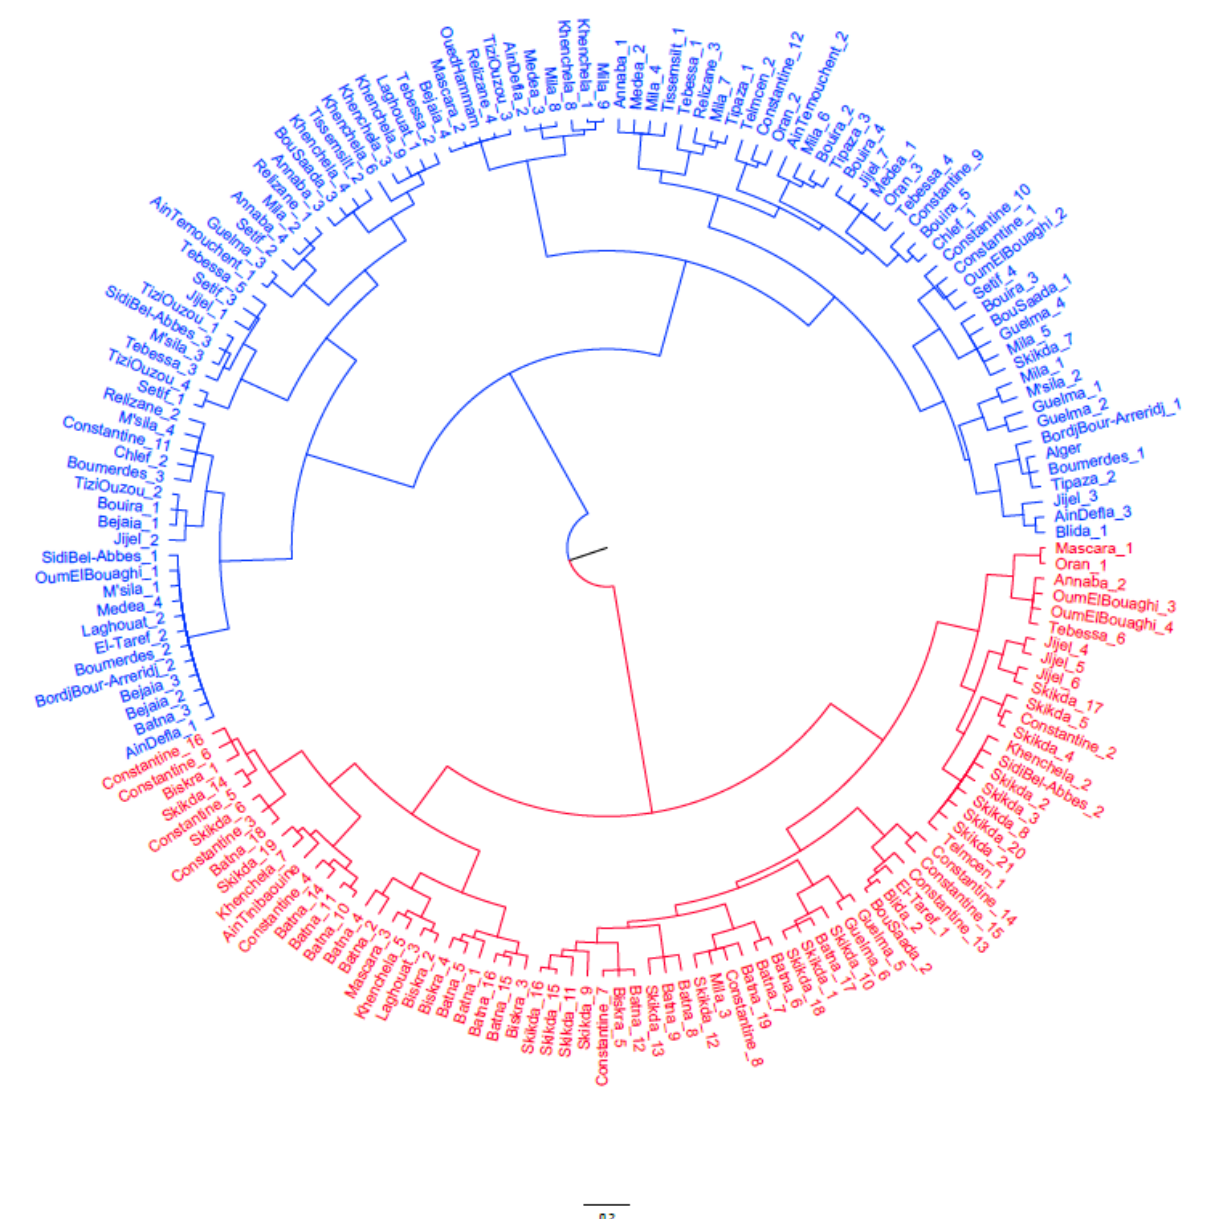
Figure 5. Dendrogram generated by Ward’s method based on morphological markers, illustrating the similarity among the 175 wild olive Algerian samples. The colors red and blue were used to distinguish between the two obtained clusters, Cluster 1 and Cluster 2.